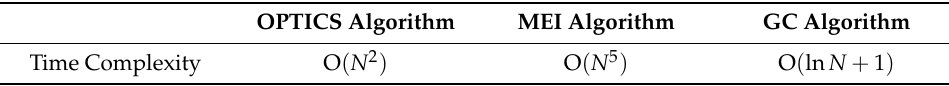
Table 1. Comparison of computational